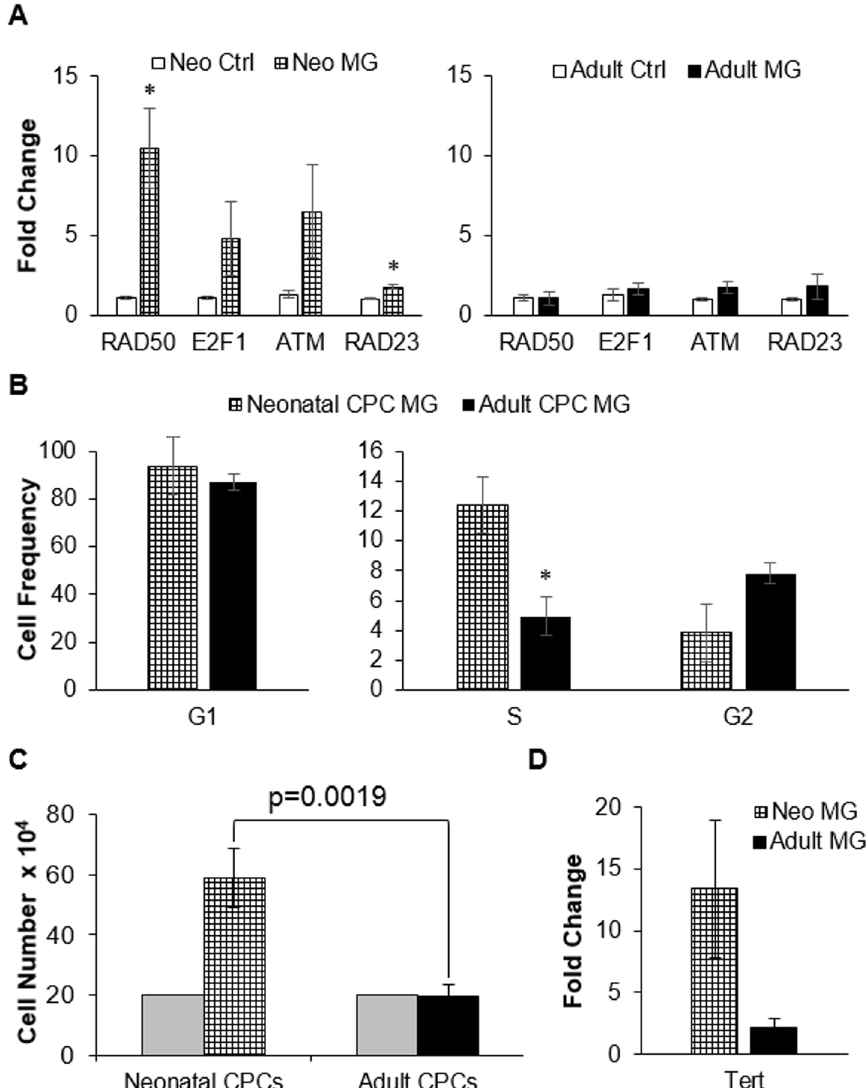
Fig 2. DNA repair and cell number after 6 – 7 days of simulated microgravity. A) DNA repair transcripts including RAD50, E2F1, ATM, RAD23 were elevated after simulated microgravity in neonatal (n = 4, run in triplicate, * = p < 0.05) but not adult CPCs (n = 3, run in triplicate). B) A significantly higher frequency of neonatal CPCs entered the S phase of the cell cycle when compared with adult CPCs in simulated microgravity (12.4% vs 4.9%, p = 0.03). G1 phase and G2 phase did not differ significantly between neonatal and adult CPCs (G1 phase — 93.3% vs 87.1%, p = 0.62 and G2 phase — 3.9% vs 7.8%, p = 0.12 respectively). C) The average number of cells after 6 – 7 days of clinorotation was significantly higher in neonatal CPCs (5.89 x 10 4 , n = 12) when compared with adult CPCs (1.95 x 10 4 , n = 11). Number of cells seeded is shown in grey. D) The expression level of human telomerase reverse transcriptase was significantly elevated in neonatal (n = 4, run in triplicate) but not adult CPCs after simulated microgravity. Fold change above matched control is